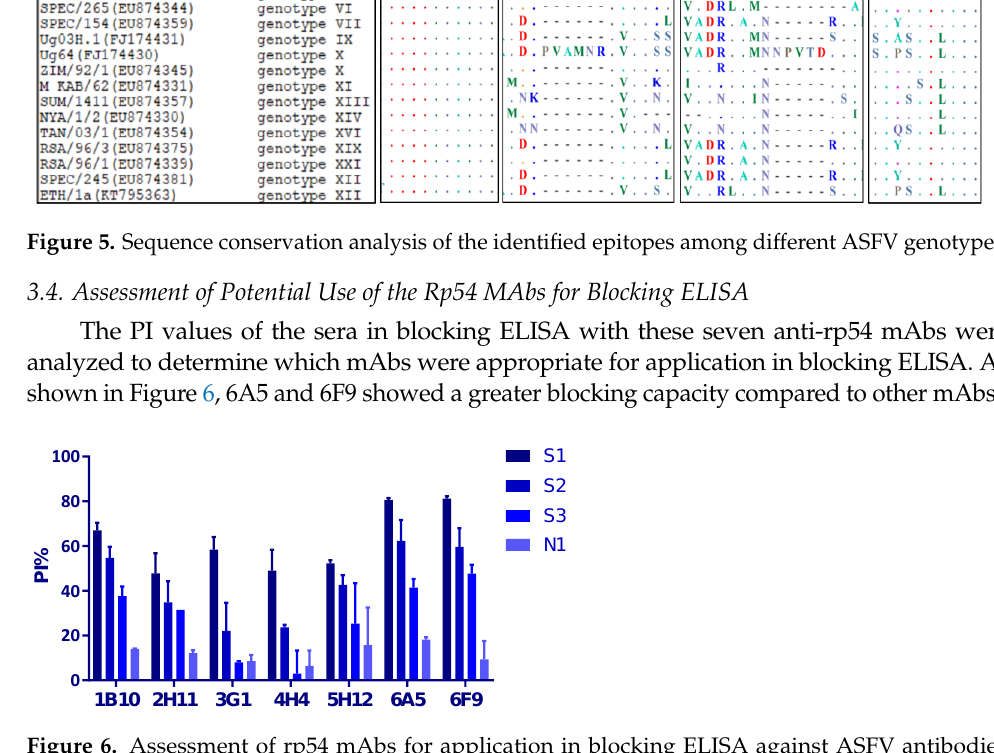
Figure 6. Assessment of rp54 mAbs for application in blocking ELISA against ASFV antibodies. The percent of inhibition of different mAbs against strong-, medium-, weak-positive (S1, S2 and S3, respectively) and negative serum (N1) samples were determined.